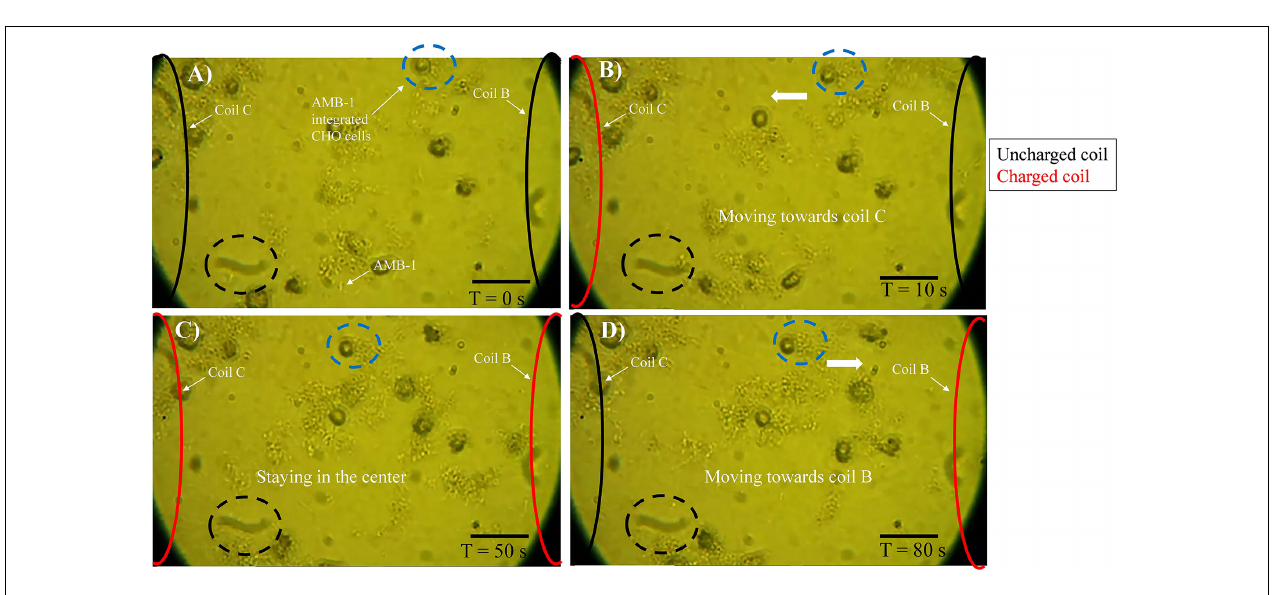
FIGURE 2 | Motility of AMB-1-integrated CHO cells with time. (A) At T = 0 s, AMB-1-integrated CHO cells are moving randomly. (B) At T = 10 s, coil C on the left is charged and an AMB-1-integrated CHO cell, highlighted by a blue dotted circle, starts to navigate toward the charged coil C. (C) At T = 50 s, coils B (right) and C (left) are charged and the AMB-1-integrated CHO cell in the blue dotted circle stays in the center. (D) At T = 80 s, only coil C (left) is discharged and the AMB-1-integrated CHO cells can be seen moving toward coil B to the right. A stationary black dotted circle is added at the bottom of every frame to serve as a reference point. Reversal was achieved in the same manner (scale bar = 50 µ m). Supplementary Videos 3, 4 show this controlled navigation of AMB-1-integrated CHO and AMB-1 cells,